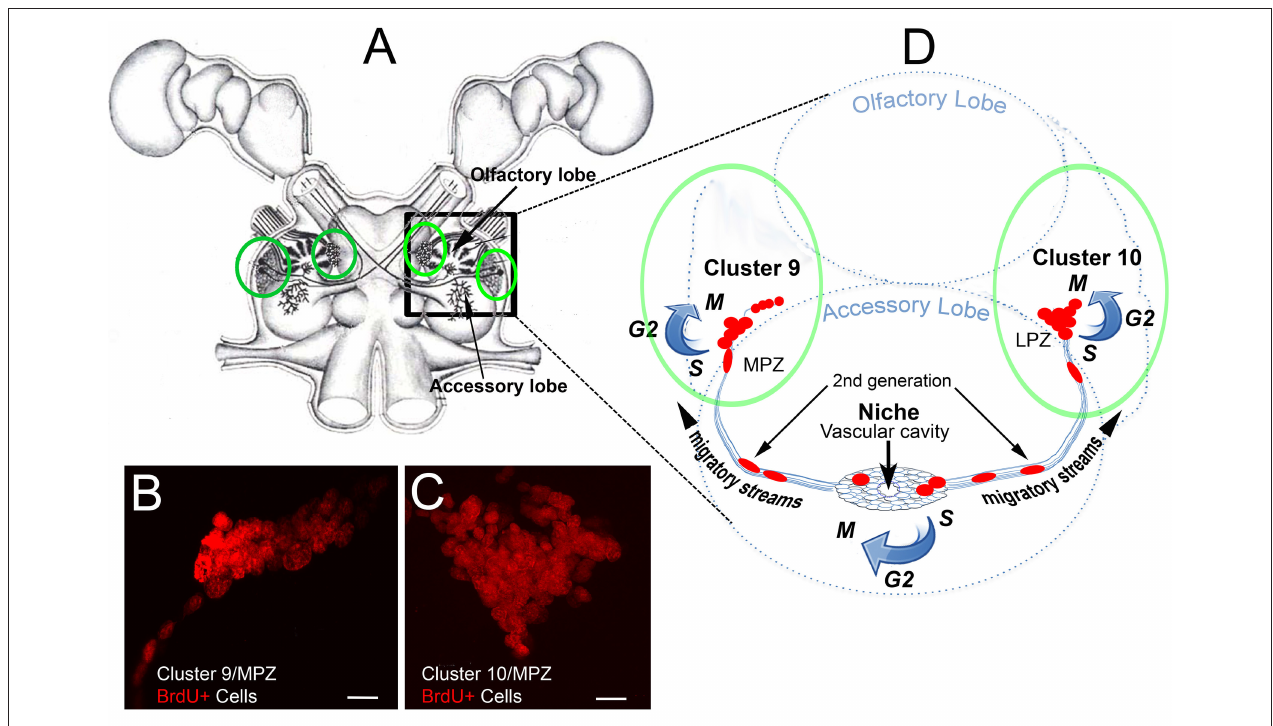
FIGURE 1 | The cellular machinery producing adult-born neurons in the crayfish brain . (A) Drawing of the eureptantian (crayfish/lobster) brain including the eyes and optic ganglia of the lateral protocerebrum, and showing the locations of the cell body clusters and neuropils in the brain (supraesophageal ganglion). Bilateral soma clusters 9 and 10 (circled in green, (A) are locations where neurogenesis persists in the adult brain, shown with bromodeoxyuridine labeling (red) of S-phase cells in (B,C) . These cell clusters lie beside two neuropil regions in the deutocerebrum, the olfactory (OL) and accessory (AL) lobes, shown diagrammatically in (D) (right hemibrain). The neurogenic niche lies on the ventral surface of the accessory lobes, just beneath the membrane ensheathing the brain. The niche contains bipolar cells that have short processes that project to the rim of a vascular cavity, and long processes that form migratory streams extending to Clusters 9 or 10, along which the daughters of 1st-generation neural precursors in the niche migrate. Scale bars: (A,B) , 20 µ